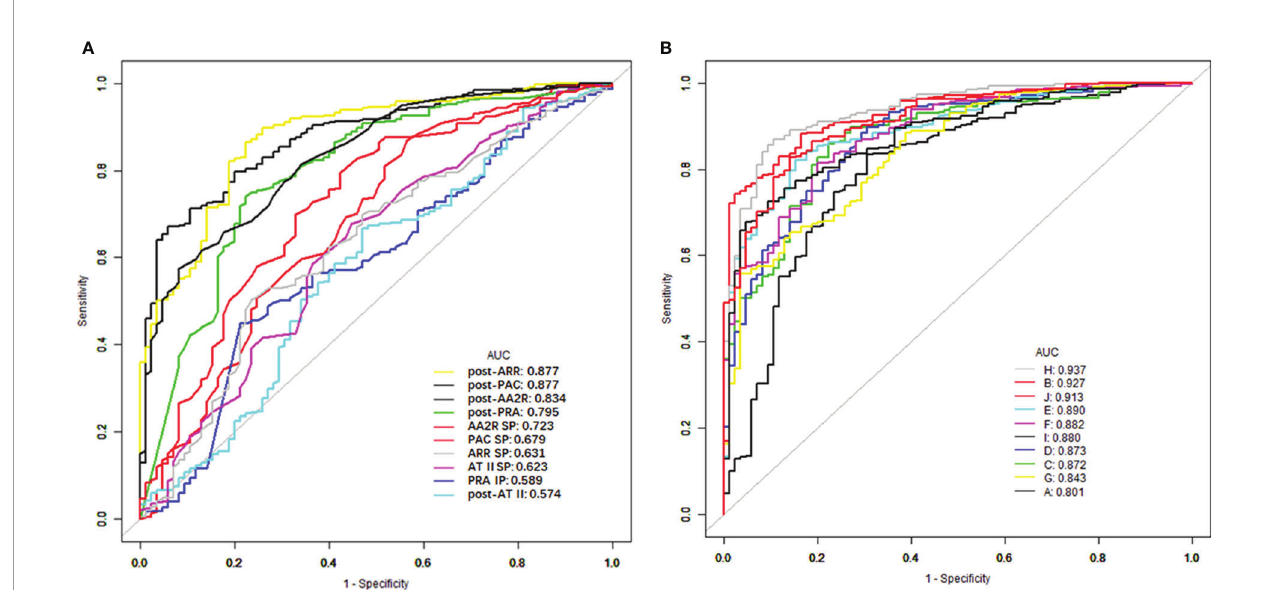
FIGURE 1 | ROC curves of different CCT-associated single (A) and combined (B) indexes for distinguishing between PA and EH. ROC, receiver operating characteristic; CCT, captopril challenge test; PA, primary aldosteronism; EH, essential hypertension; AUC, area under the ROC curve; PAC, plasma aldosterone concentration; PRA, plasma renin activity; AT II, angiotensin II; ARR, aldosterone to renin ratio; AA2R, aldosterone to angiotensin II ratio; Post-PAC/PRA/AT II/ARR/ AA2R, PAC/PRA/AT II/ARR/AA2R after the CCT; PAC/ATII/ARR/AA2R SP, suppression percentage of PAC/ATII/ARR/AA2R in the CCT; PRA IP, increasing percentage of PRA in the CCT; A, post-PRA + AA2R SP; B, post-PRA + post-PAC; C, post-PRA + post-ARR; D, post-PRA + post-AA2R; E, AA2R SP + post-PAC; F, AA2R SP + post-ARR; G, AA2R SP + post-AA2R; H, post-PAC + post-ARR; I, post-PAC + post-AA2R; J, post-ARR +